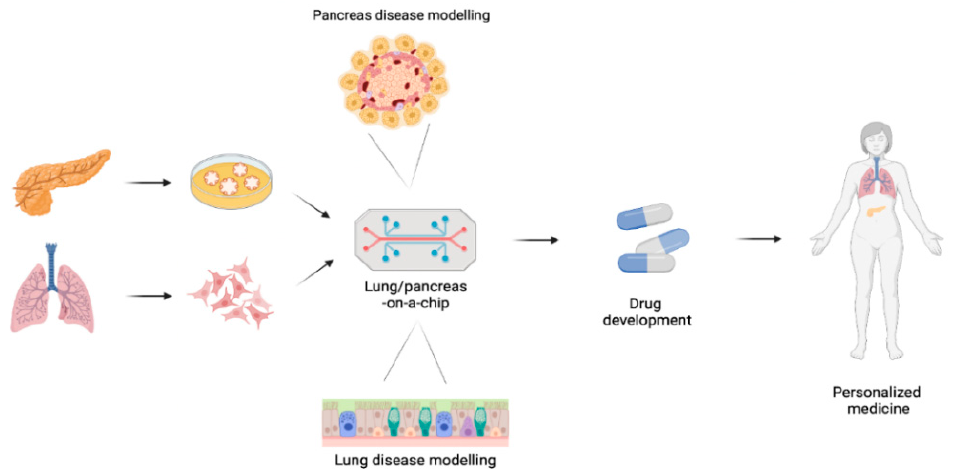
Figure 3. Graphical representation of lung and pancreas on-a-chip development for disease modeling and drug development for personalized medicine. To generate pancreas disease modeling, pancreatic ductal epithelial cells and pancreatic islets cells can be seeded into microfluid systems. This pancreas on-a-chip may be used to study CFTR-related disorders and drug development in CF. Moreover, airway or alveolar epithelial cells with pulmonary microvascular endothelial cells can be seeded into the device to generate lung-on-a-chip in order to investigate the in vivo environment of human airways and drug development in